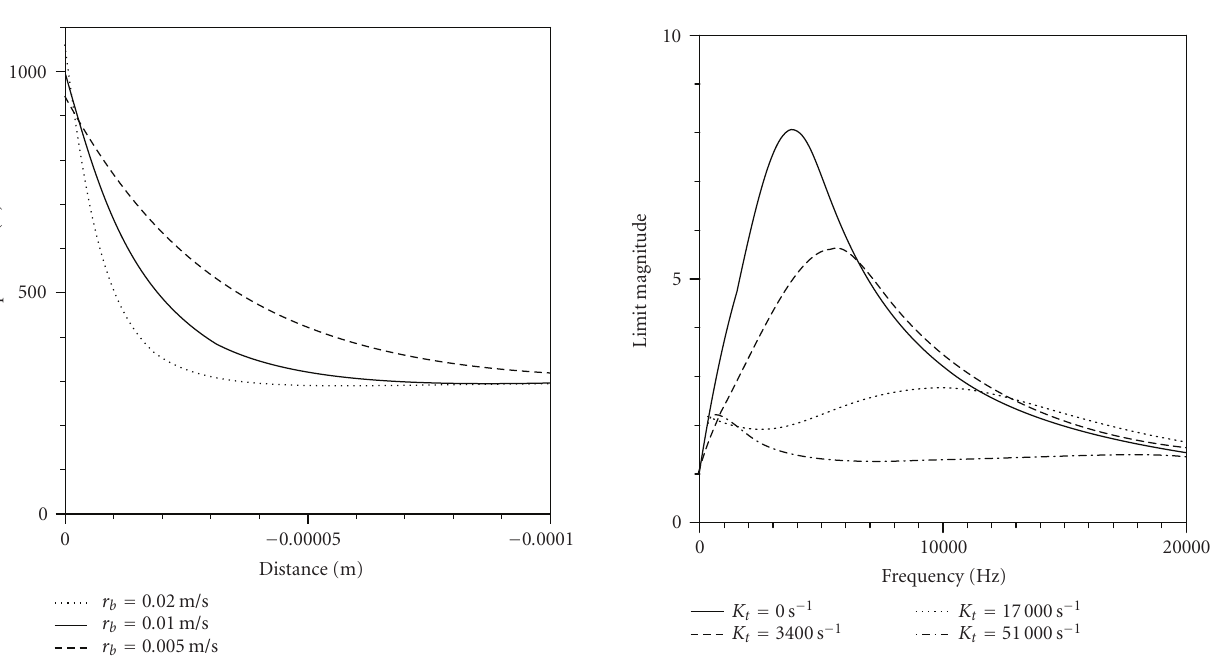
Figure 3: Steady-state temperature distribution in regressing solid propellant.